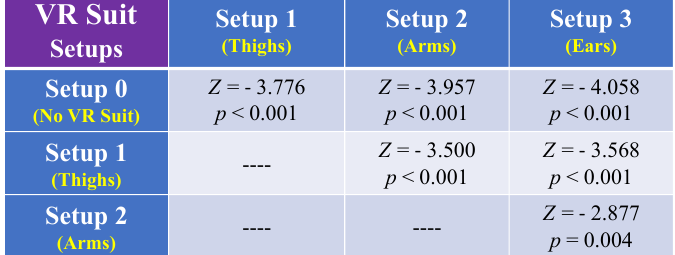
Figure 10. Wilcoxon test results on desire to use the